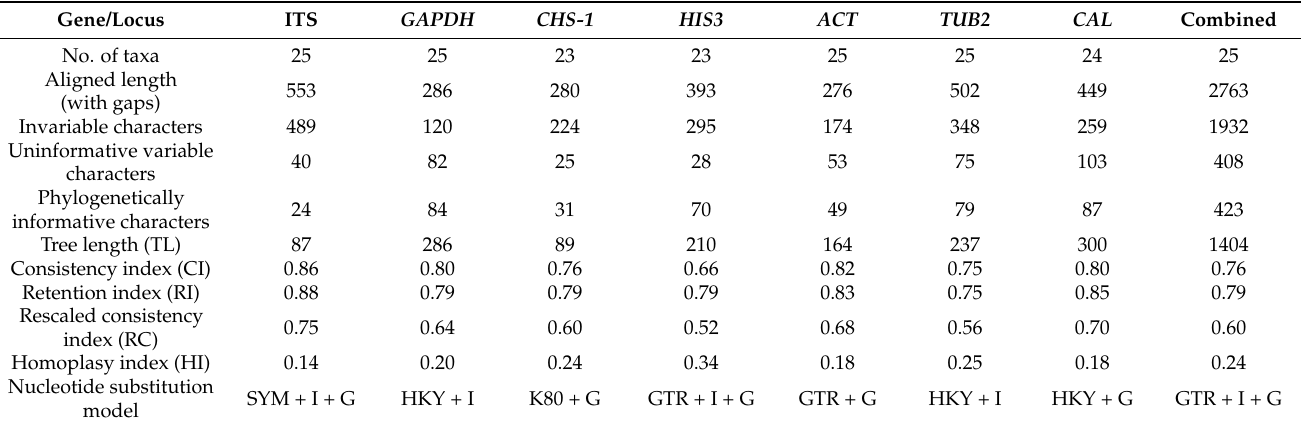
Table 4. Comparison of alignment properties in parsimony analyses of gene/locus and nucleotide substitution models used in phylogenetic analyses of C. boninense species complex.